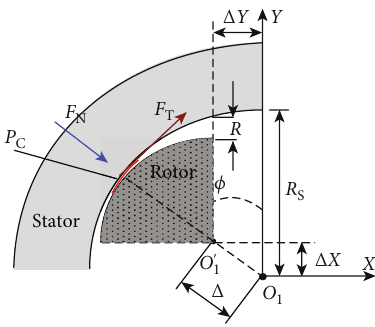
Figure 2: Forces acting on the rotor-stator rub with